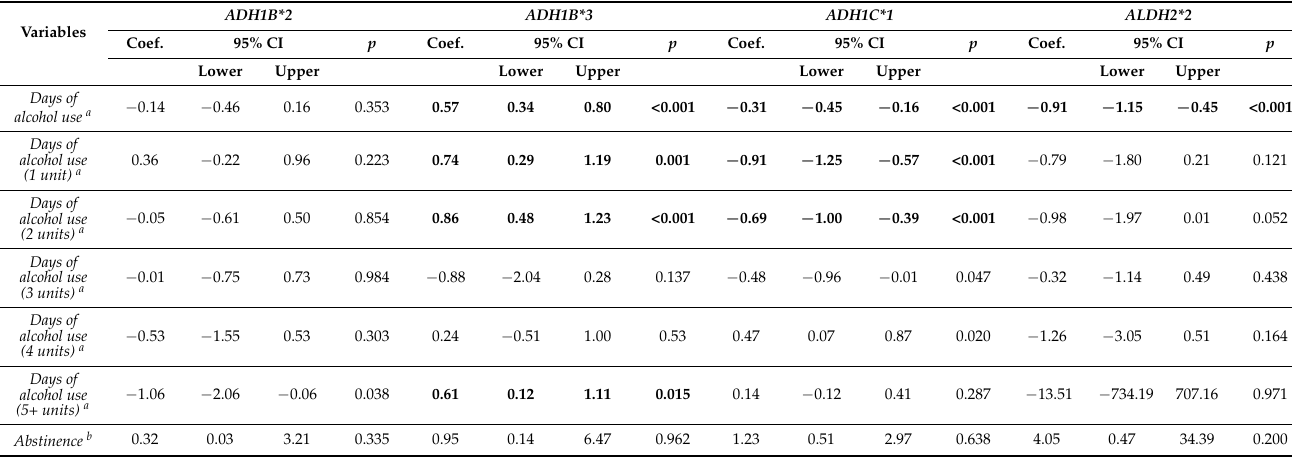
Table 4. Correlation between clinical outcomes and genotyping (ADH1B*2, ADH1B*3, ADH1C*1 and ALDH2*2) through re- gression models adjusted for previous outpatient treatment, family history of alcohol problems and alcohol-related diseases. ADH1B*2 ADH1B*3 ADH1C*1 ALDH2*2 Variables Coef. 95%